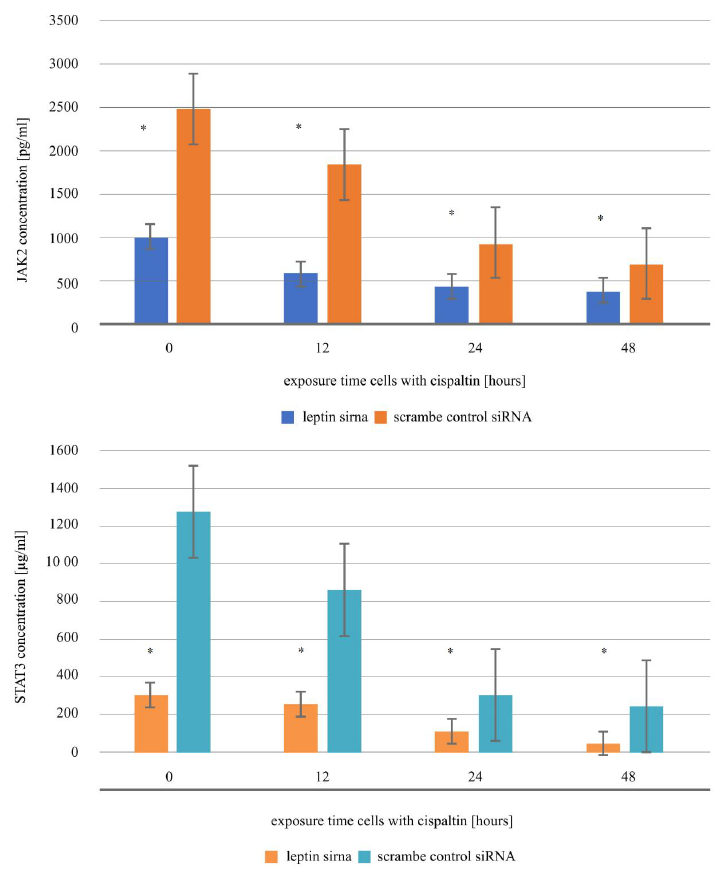
Figure 6. Leptin siRNA inhibited JAK2 and STAT3 gene expression in the Ishikawa endometrial cancer cell line treated with cisplatin and in the control culture (*—statistically significant differences p < 0.05).